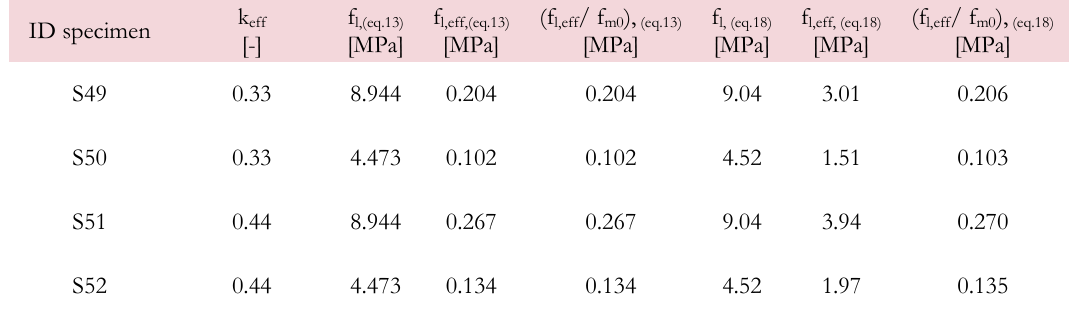
Table 11.B: Geometrical characteristics and experimental results